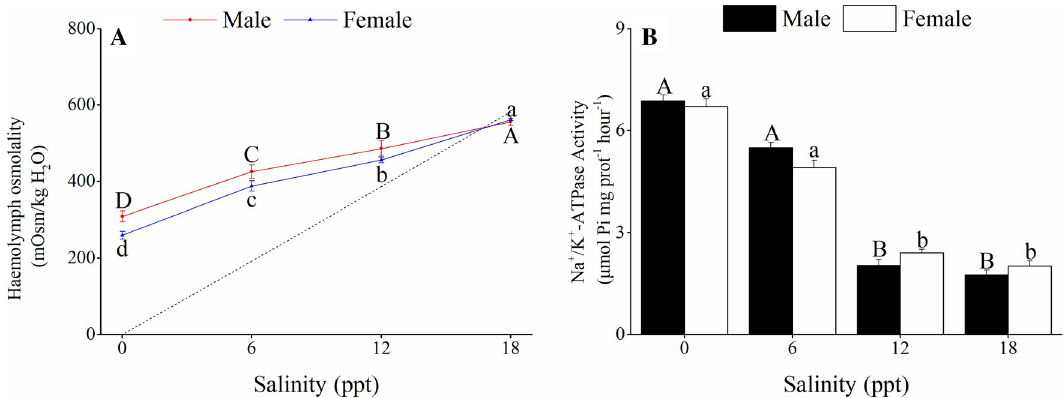
Figure 2. Haemolymph osmolality (A) and gill Na + /K + ATPase activities (B) of C. dehaani crabs after exposure to salinity changes for 96 h. Values are mean ± SE, N = 4. Different letters above the data indicate significant differences between the salinity treatments, as assessed using Tukey’s tests ( P <